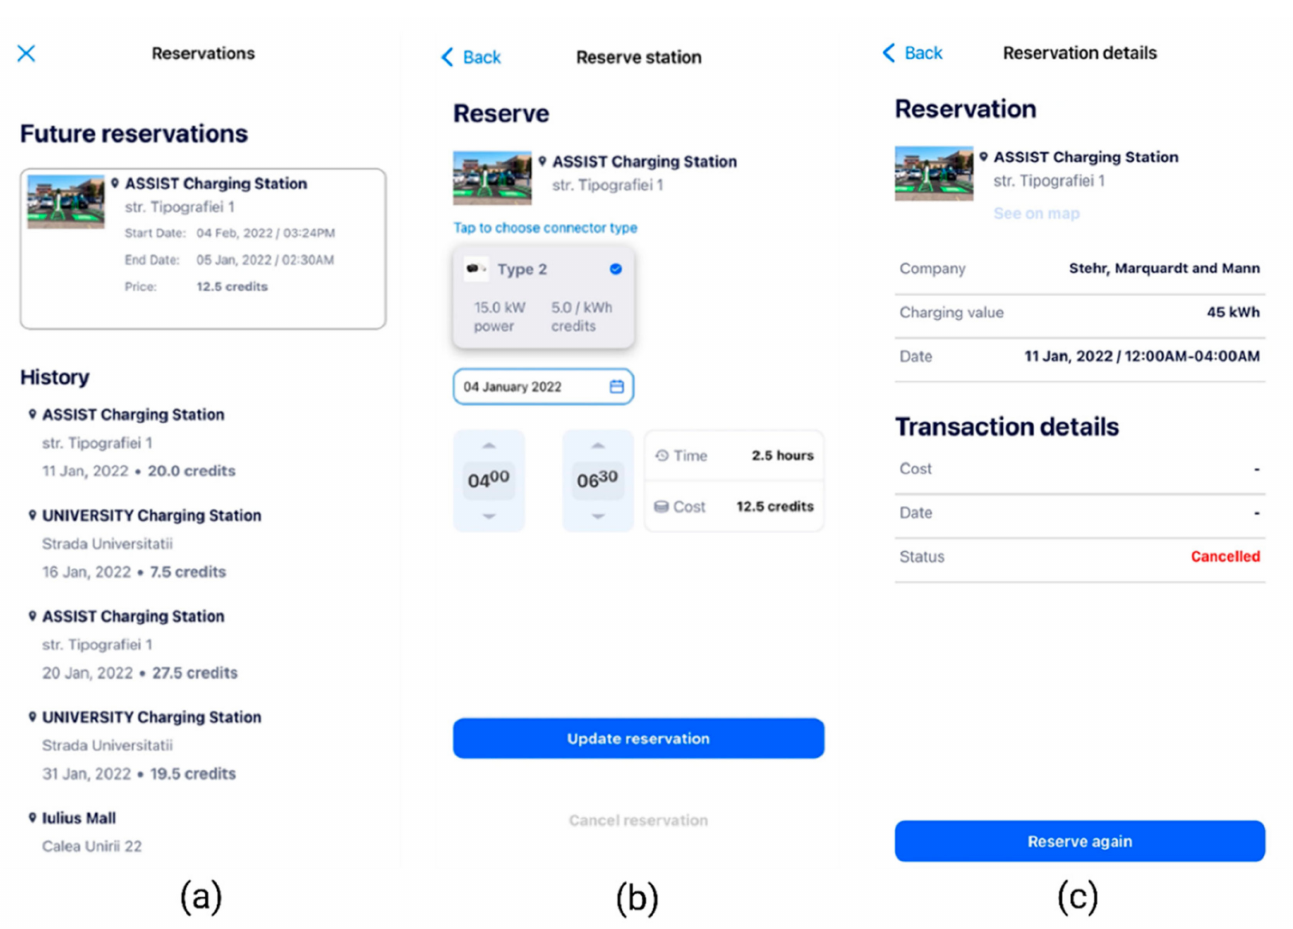
Figure 9. Smart EVC—Future reservations visualization. ( a ) Reservations history; ( b ) Update reservation screen; ( c ) Visualisation of a past reservation details, with possibility to reserve